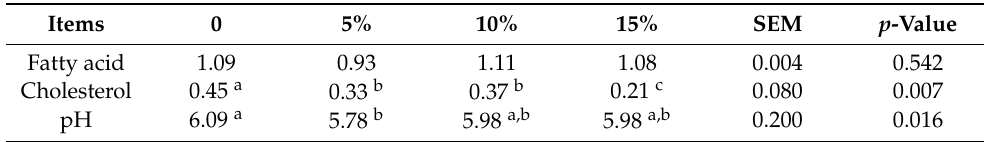
Table 6. Effects of adding fermented feed on the fatty acids, cholesterol, and pH of the breast muscle of broilers.